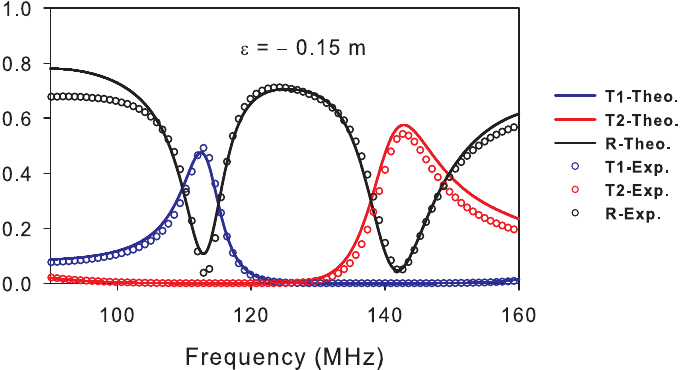
Figure 5. Theoretical (continuous lines) and experimental (open circles) transmission and reflec- tion coefficients as a function of the frequency along the ports 1 (blue curves) and 2 (red curves). The reflection coefficient is given by the black curves. The results are presented for ε = − 0.15 m. The lengths of different cables are chosen according to Equations